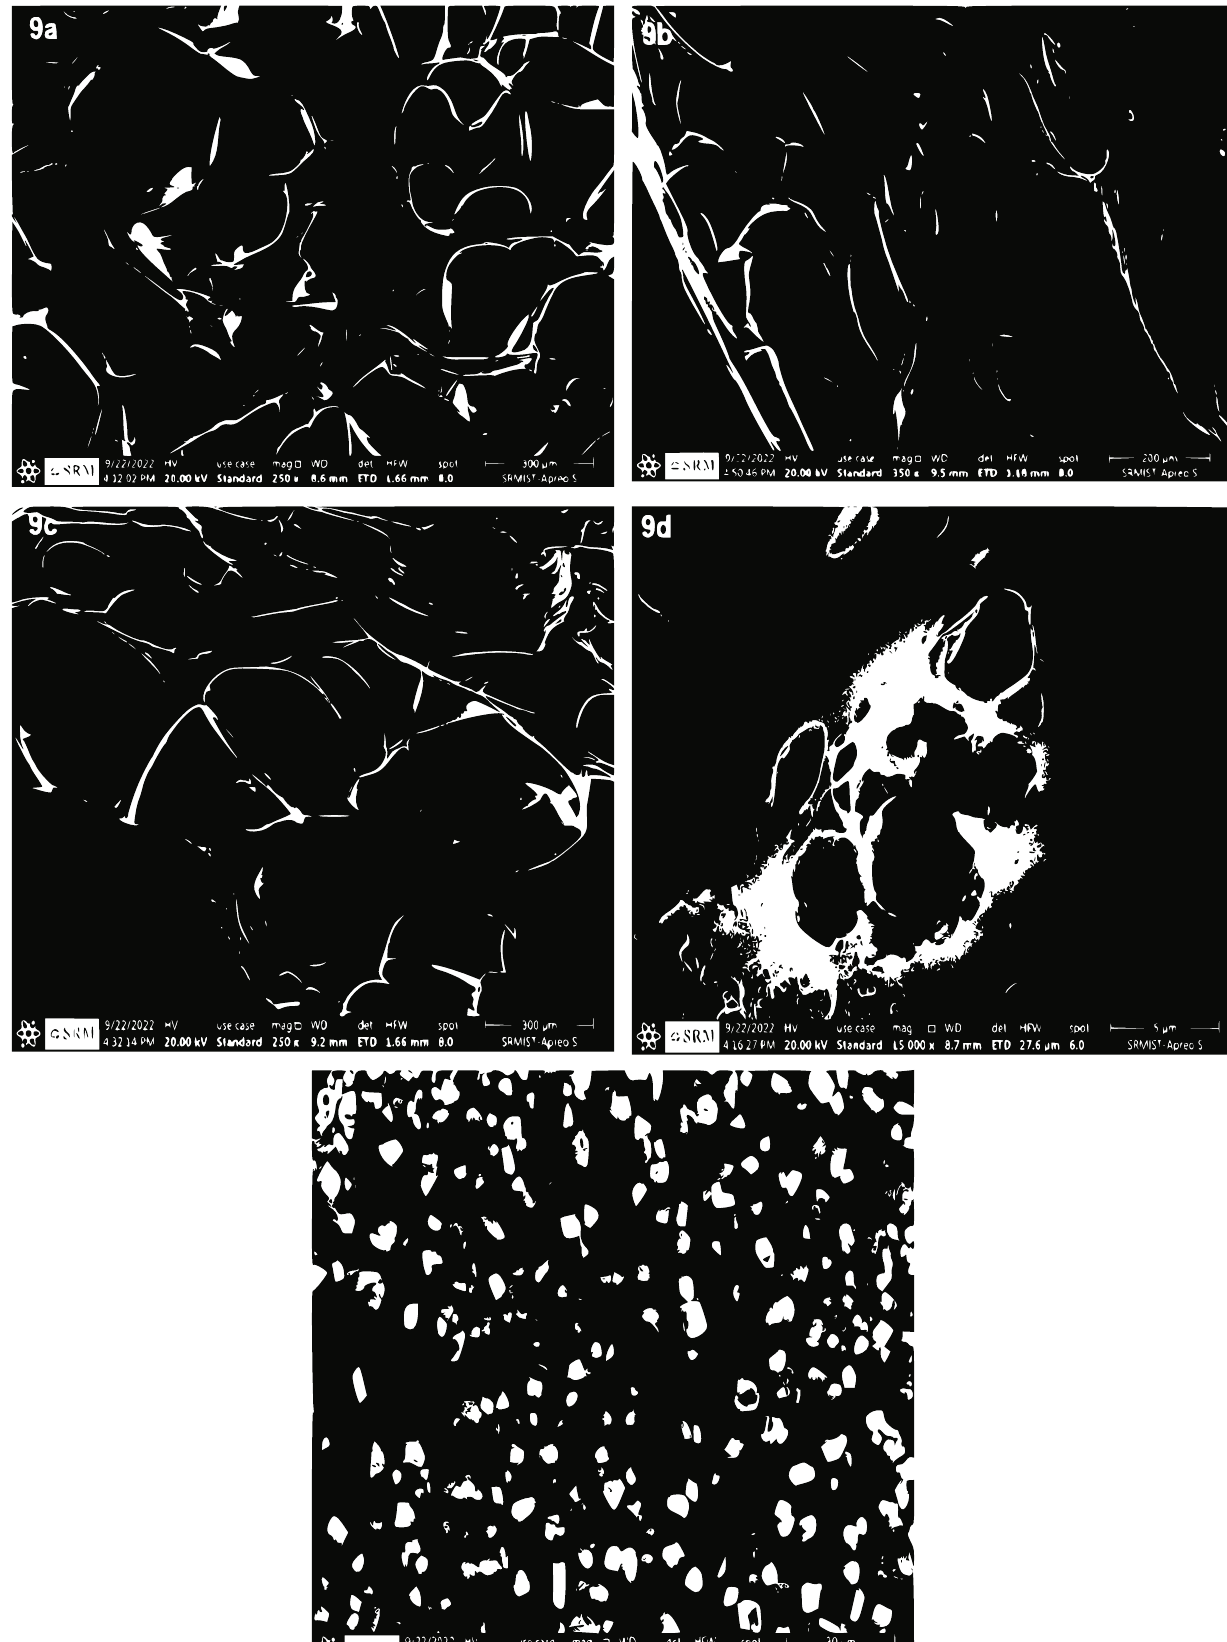
Figure 9: FESEM micrographs of (a, b, c, and d) hydrogels H2-G3 to H2-H5 and (e) hydrogel